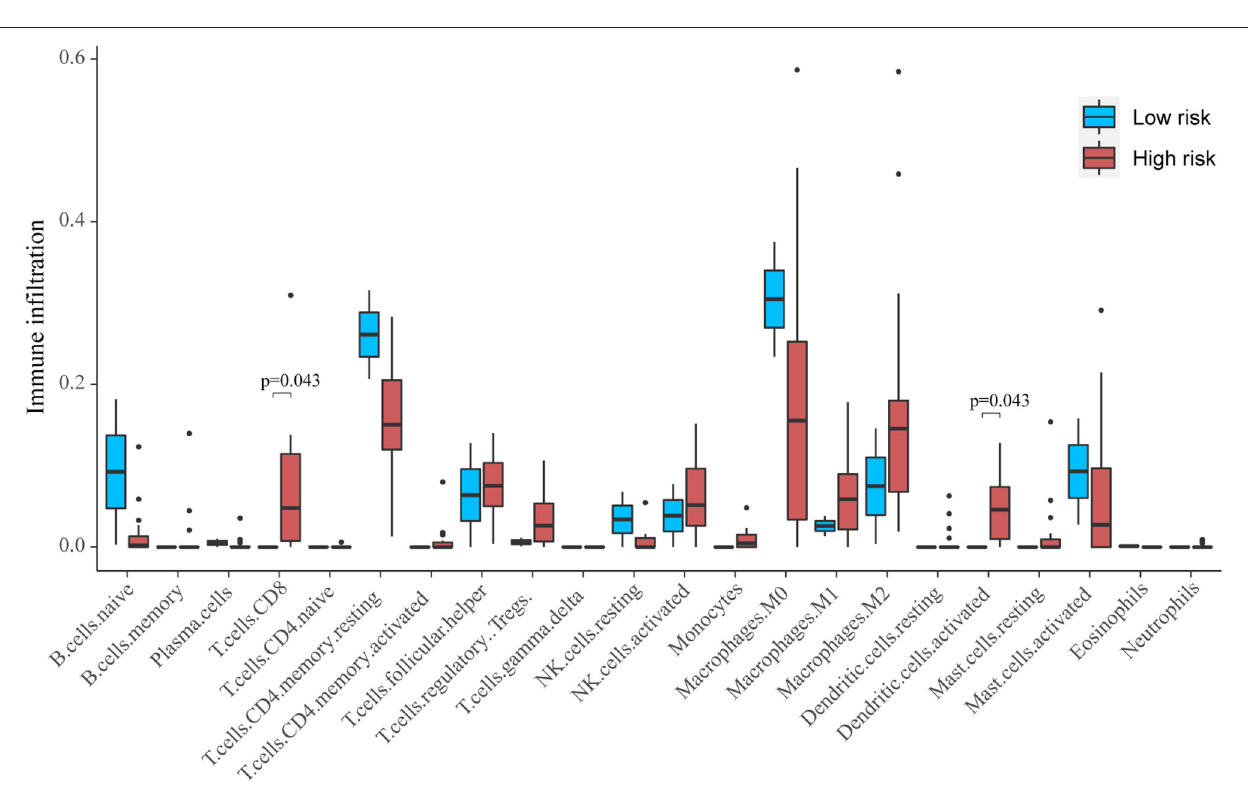
FIGURE 5 | The profiles of immune infiltration between the high-risk and low-risk score